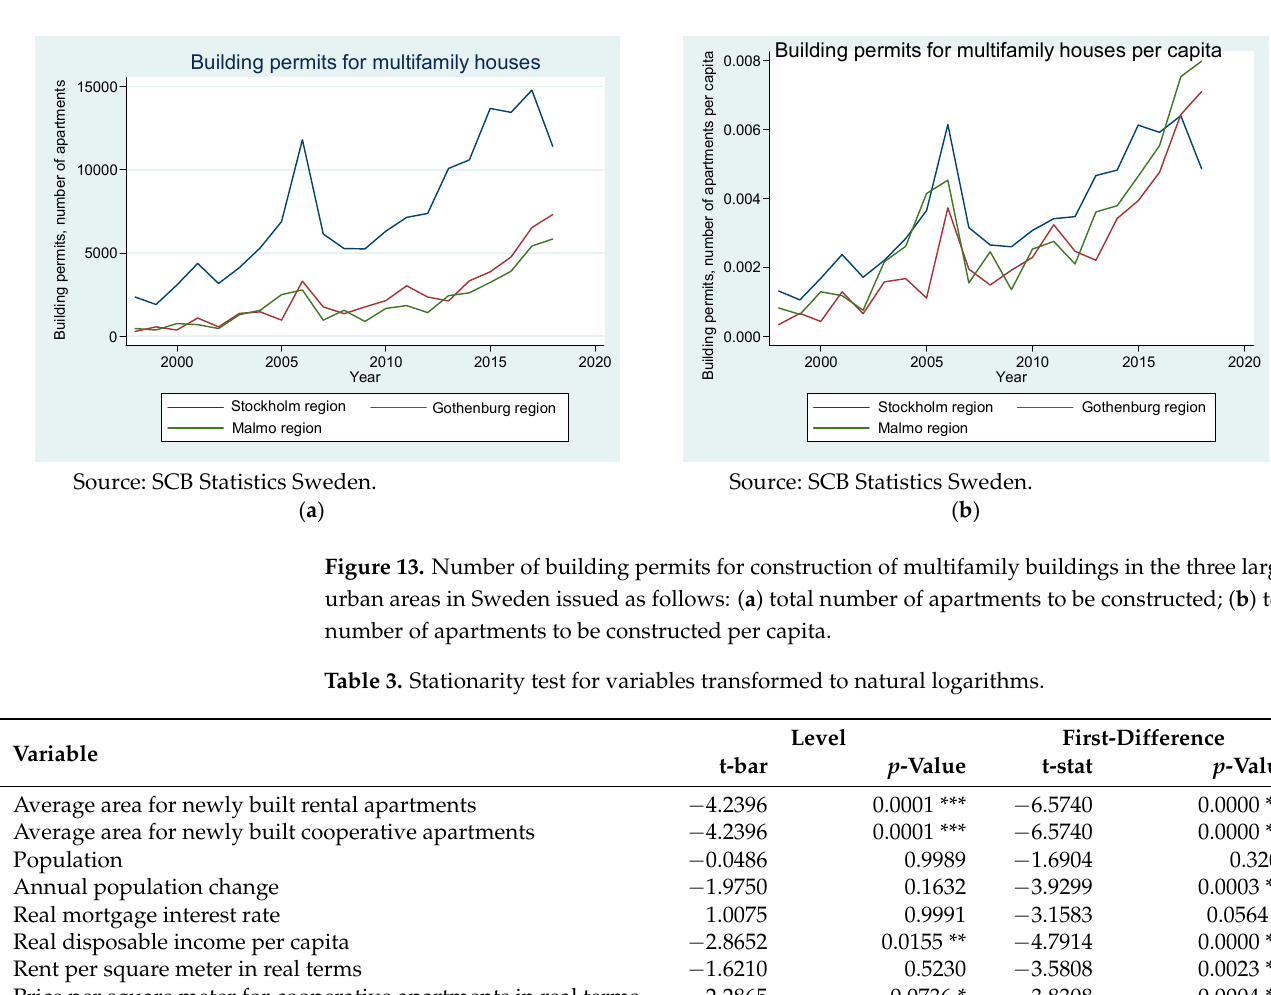
Table 3. Stationarity test for variables transformed to natural logarithms.